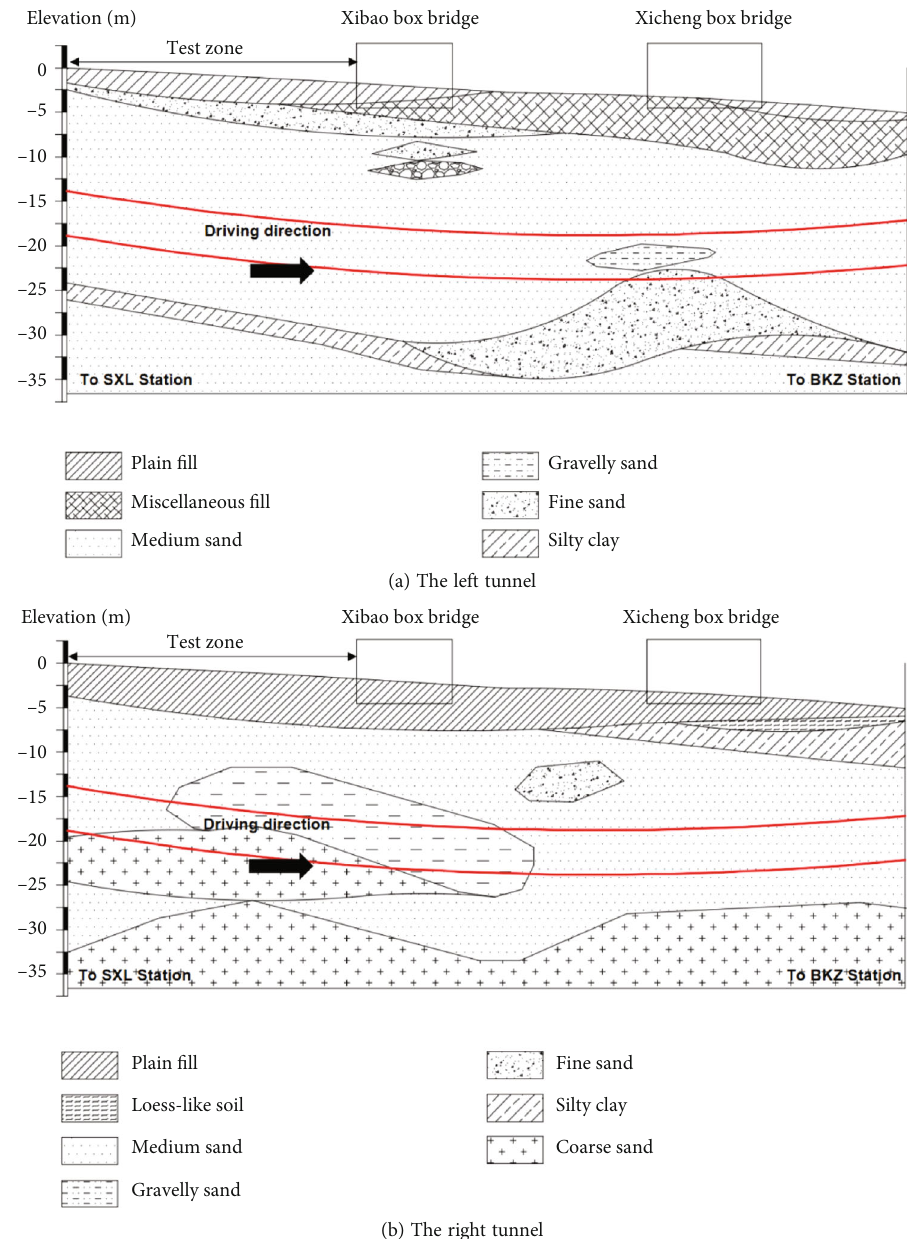
Figure 2: Longitudinal pro fi le of the tunnels, the box bridges and geological